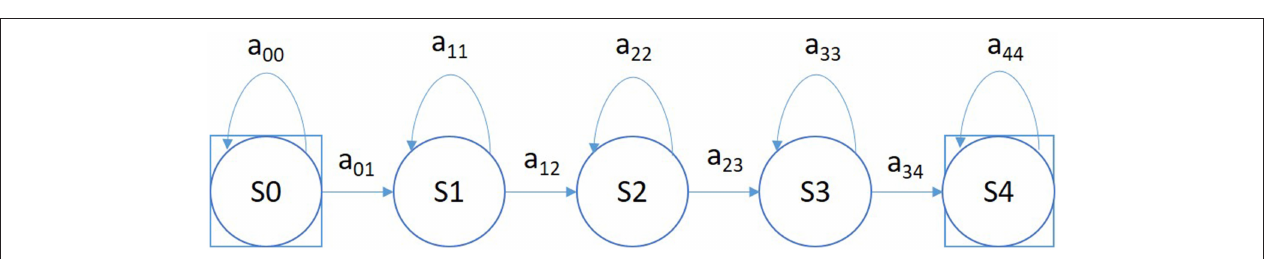
Frontiers in Human Neuroscience |